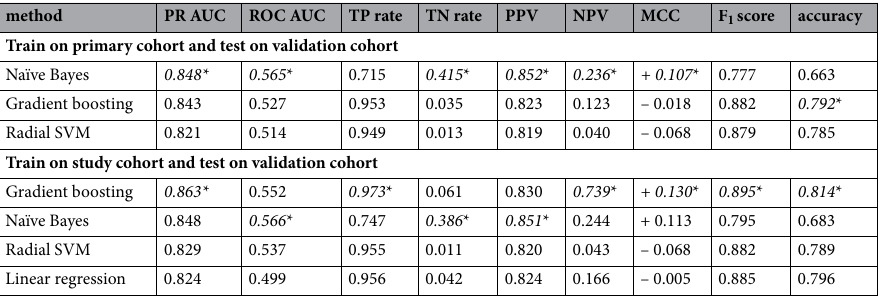
Table 7. Results of the survival prediction made with machine learning classifiers, including standard deviation, with training phase done on the Norwegian primary cohort or study cohort 87 and testing phase done on the South Korean external validation cohort 96 . Mean results of 100 executions with random selection of the elements in the training set and test set, with ROSE oversampling 97 applied to the training set. σ : standard deviation. Admissions of survived patients: positives data instances (class 1). Admissions of deceased patients: negative data instances (class 0). Linear SVM: support vector machine with linear kernel. Optimized cost regularization hyper-parameter of the linear SVM, most frequently selected C by the MCC-based grid search: C = 0.01 for primary cohort (63 times out of 100) and C = 0.001 for study cohort (51 times out of 100). Radial SVM: support vector machine with radial Gaussian kernel. Optimized cost regularization of the radial SVM, most frequently selected C by the MCC-based grid search: C = 0.1 for the primary cohort (56 times out of 100) and for the study cohort (51 times out of 100). MCC: Matthews correlation coefficient. MCC worst value = − 1 and best value = + 1 . TP rate: true positive rate, sensitivity, recall. TN rate: true negative rate, specificity. PR: precision-recall curve. PPV: positive predictive value, precision. NPV: negative predictive value. ROC: receiver operating characteristic curve. AUC: area under the curve. F 1 score, accuracy, TP rate, TN rate, PPV, NPV, PR AUC, ROC AUC: worst value = 0 and best value = + 1 . We report the formulas of these rates in the Supplementary Information, and the same results including the standard deviations in Table S3. ROSE minority class probability: p = 0.5 for SVMs; p = 0.38 for gradient boosting, naïve Bayes, and linear regression in the primary cohort; p = 0.45 for gradient boosting, naïve Bayes, and linear regression in the study cohort. We highlighted in italic and with an asterisk * the top result for each statistical indicator. We did not report the results of linear regression trained on the primary cohort and the results of the linear SVM on both the cohorts because these methods predicted all positives in the validation scores for positive data instances (sensitivity and precision) but low scores for negative data instances (specificity and NPV). Naïve Bayes achieved the top specificity both when trained on the primary cohort (0.415) and when trained on the study cohort (0.386). Differently from the other tests we made, some methods failed in correctly predicting any negative data instances: the linear SVM method classified all the validation set data instances as positive, both when trained